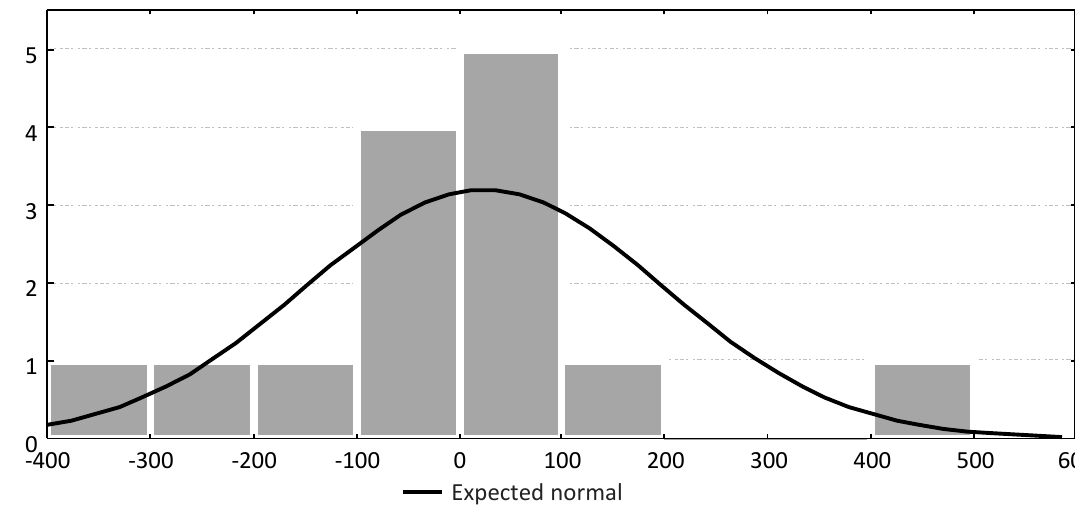
Distribution: Excesses